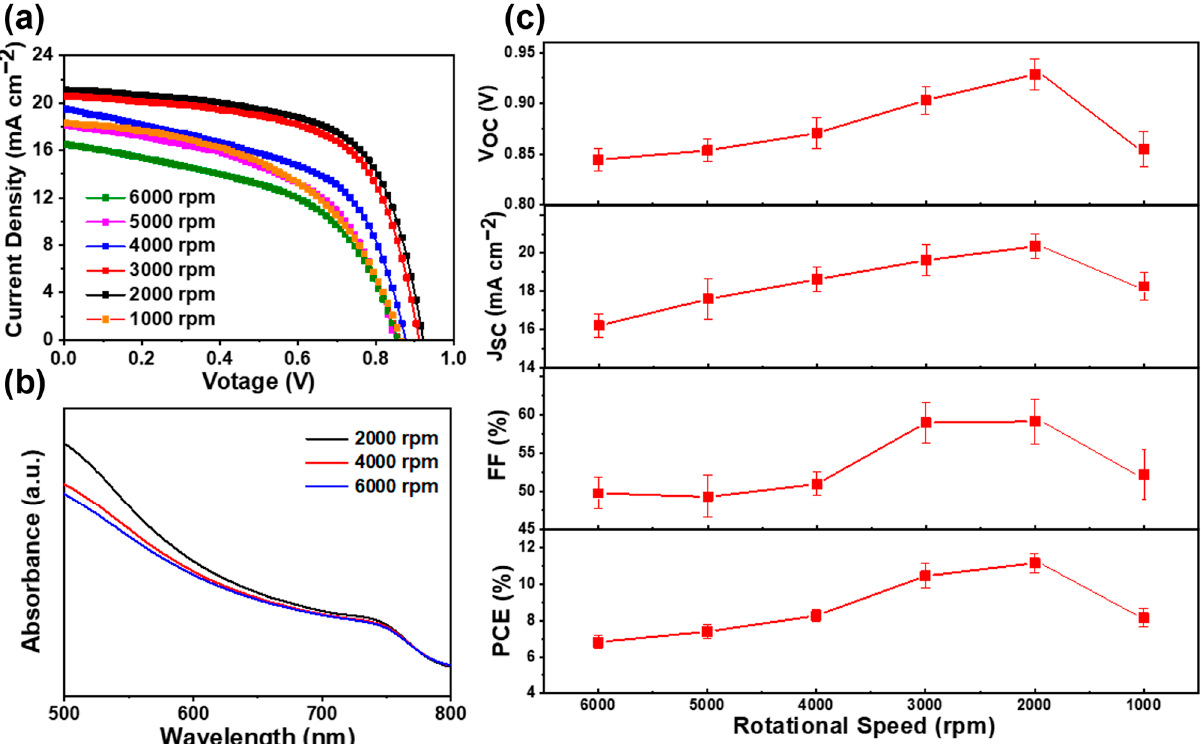
Table 1. The solar cells fabricated under a low rotating speed of PbI 2 have larger R SH than those fabricated under a high rotating speed, which was consistent with the improved FF and V OC observed in these solar cells.